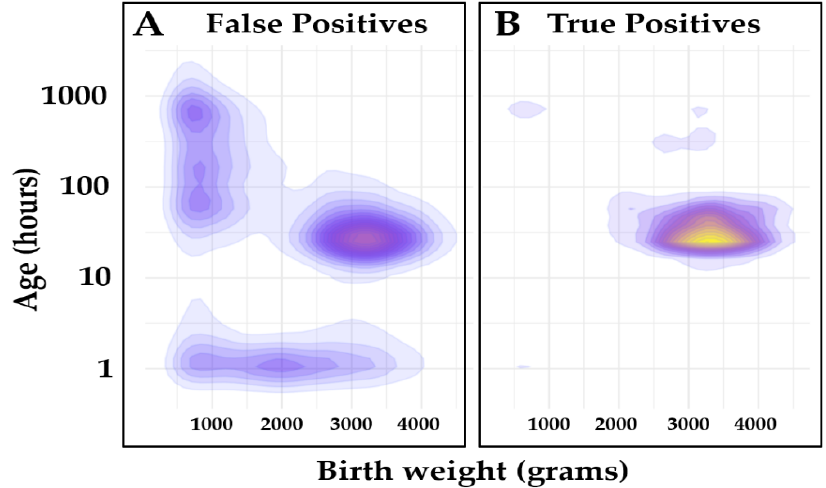
Figure 3. Covariate distribution of the Validation set. Legend: Covariate density plot of false positive (N = 10,556) and true positive (N = 915) cases from the Validation set. (Panel A ): False positives; (Panel B ): True positives. Kernel density estimation (KDE) function [31] was used to calculate probability density function of each class, and it was displayed using a contour plot. The unit values are the same as the input unit values. The scale is log10 on the Y axis and linear on the X axis of the plot. Color gradients are relative to case count.